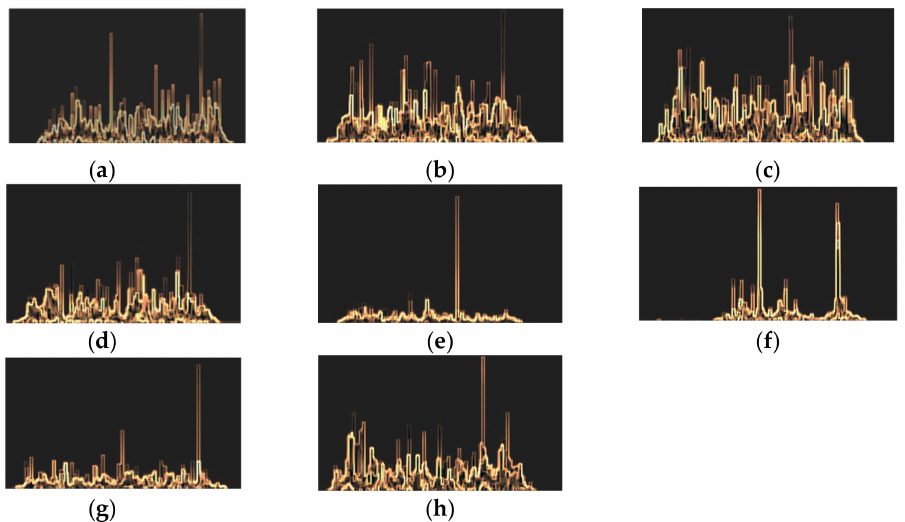
Figure 8. ( a – c ) Lowering process; ( d ) interfering collision process in the rising process; ( e – g ) lifting process; ( h ) interfering collision process in the lowering